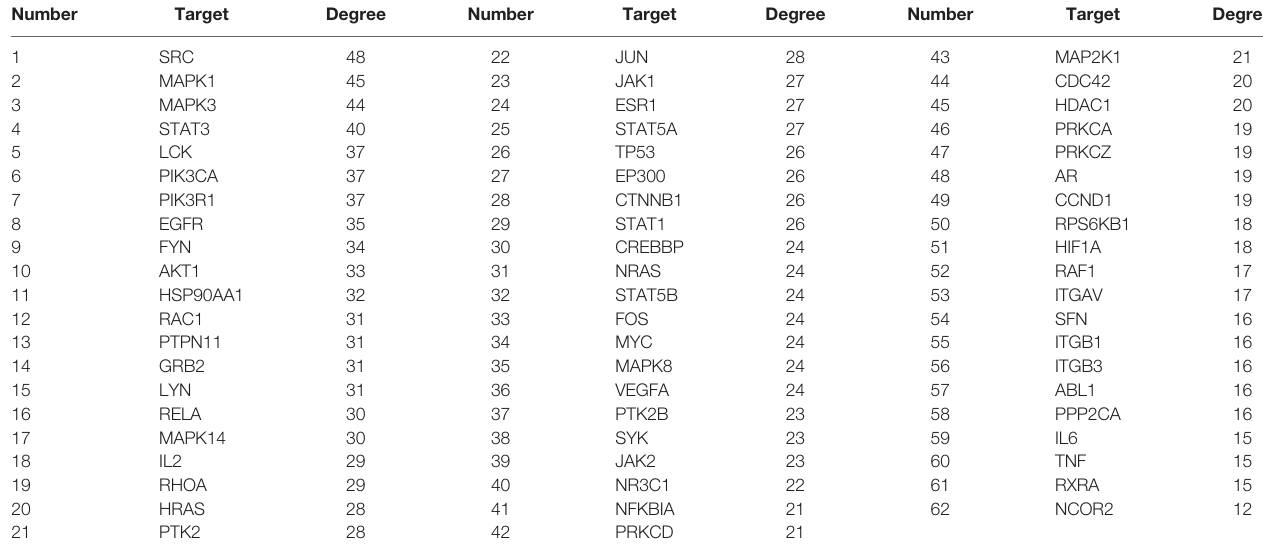
TABLE 2 | Sixty-two hub targets of HMMCR for